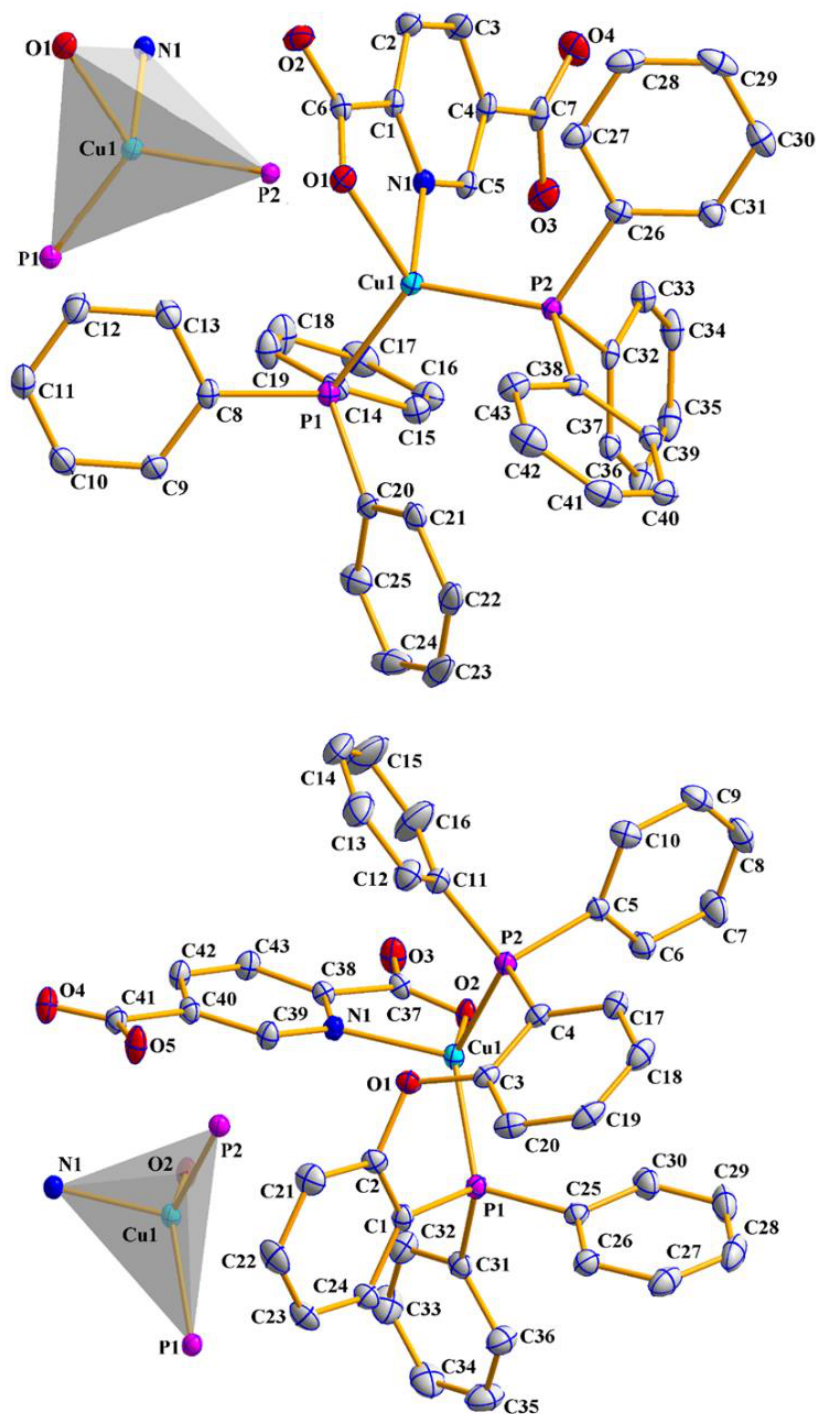
Figure 1. Molecular structures and metal coordination polyhedra for [Cu(HL)(PPh 3 ) 2 ] in 1 ( top ) and [Cu(HL)(POP)] in 2 ( bottom ). Hydrogen atoms and uncoordinated solvent molecules were omitted for clarity. Ellipsoids are shown at the 50% probability level.